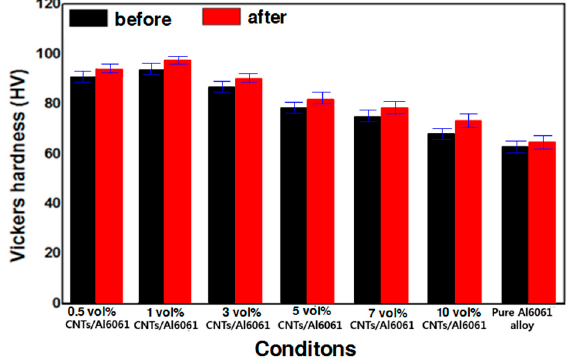
Figure 9. Vickers hardness in the direction of compaction after open-die forging.